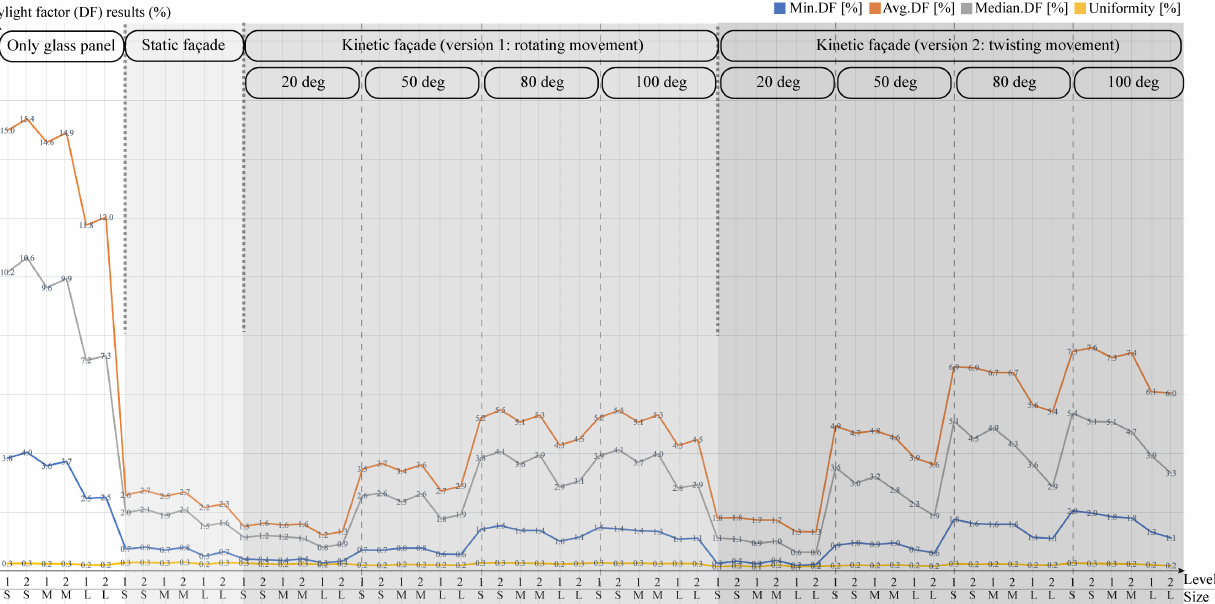
Figure 12. Comparing a façade in terms of daylight